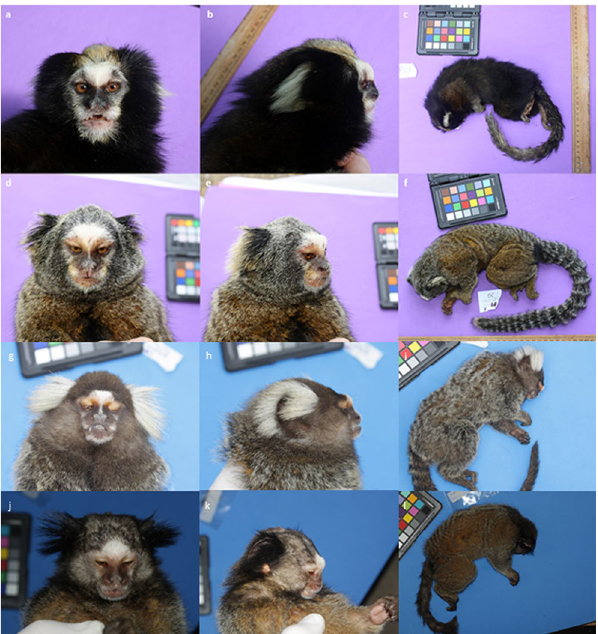
Figure 2. Callithrix aurita (above) and an example of hybrid phenotypes (below) of the sampled individuals of Callithrix sp. : ( a , d ) loss of the yellowish supracranial line peculiar of C. aurita ; ( b , e ) short ear tufts, in some cases fan-shaped with darker color; c , f ) lighter color of the body with eventual grooves; ( g – i ) C. jacchus phenotype; ( j – l ) C. penicillata phenotype (Photographs by R. S. Carvalho).